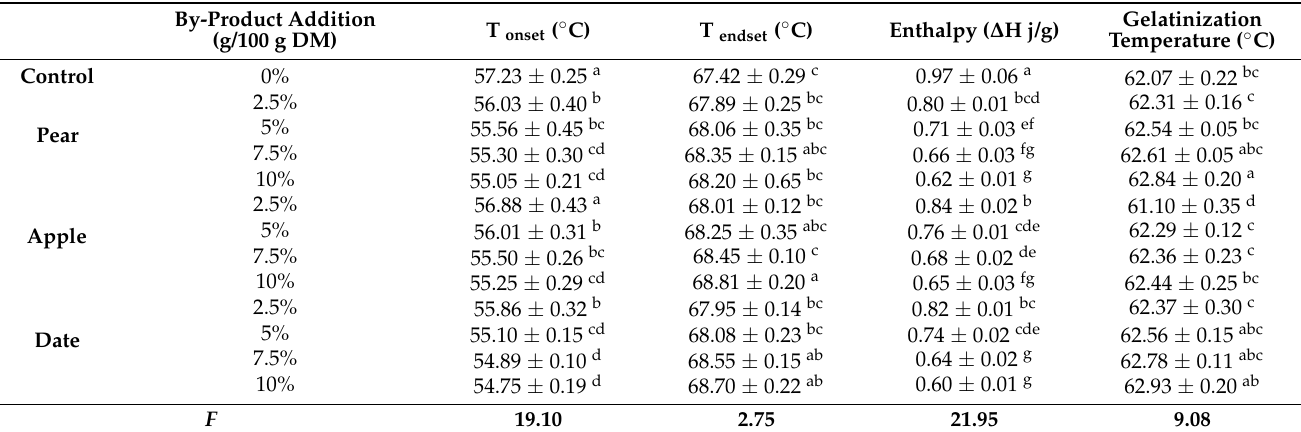
Table 7. Thermal gelling properties of pasta